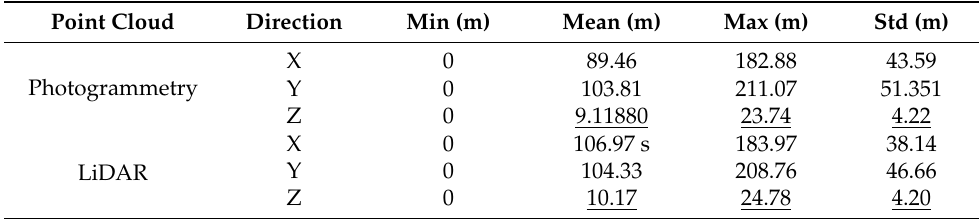
Table 2. Statistical parameters of the photogrammetric and LiDAR point clouds.